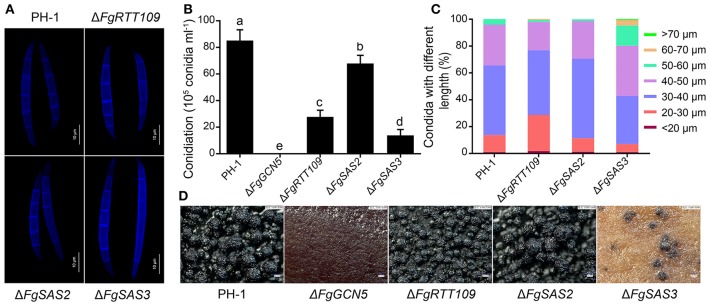
Morphologies of conidia and the formation of perithecia. (A) Microscopic observations of conidial morphology of PH-1, ΔFgRTT109, ΔFgSAS2, and ΔFgSAS3. Differential interference contrast (DIC) images of conidia stained with calcofluor white were captured with an electronic microscope. Scale bar = 10 μm. (B) The number of conidia produced by PH-1, ΔFgRTT109, ΔFgSAS2 and ΔFgSAS3 strains. Error bars indicate the standard deviations of three repeated experiments. Values on the bars followed by the same letter are not significantly different at P = 0.05. (C) Percentages of conidia with different lengths in PH-1, ΔFgRTT109, ΔFgSAS2 and ΔFgSAS3 strains. (D) Microscopic observations of perithecia. Perithecia formation of PH-1, ΔFgGCN5, ΔFgRTT109, ΔFgSAS2, and ΔFgSAS3 were photographed by digital microscope VHX-2000 at 2 weeks post-fertilization after sexual induction on carrot agar. Mutant ΔFgGCN5 failed to produce perithecia.